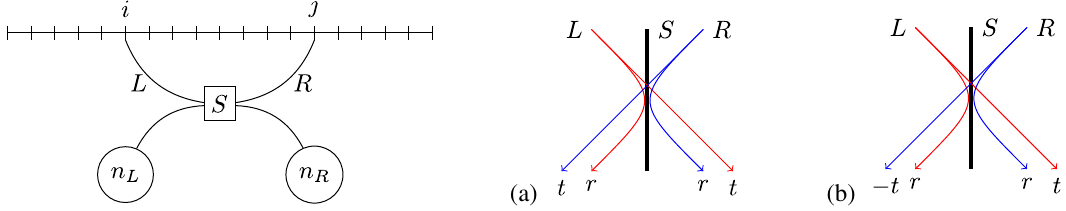
FIG. 6. Two wires attached to the system at sites i and j such that only one fermion can enter at a time. First, the fermions in the wire are allowed to interact via the beam splitter S . Then, their occupation numbers n measurement (a), one uses a symmetric beam splitter, which allows one to measure the imaginary part of G (b), one needs to use a beam splitter where the fermion that is transmitted from R to L accumulates a phase π , while it does not accumulate this phase when being transmitted in the other direction. In this way, one can measure the real part of G